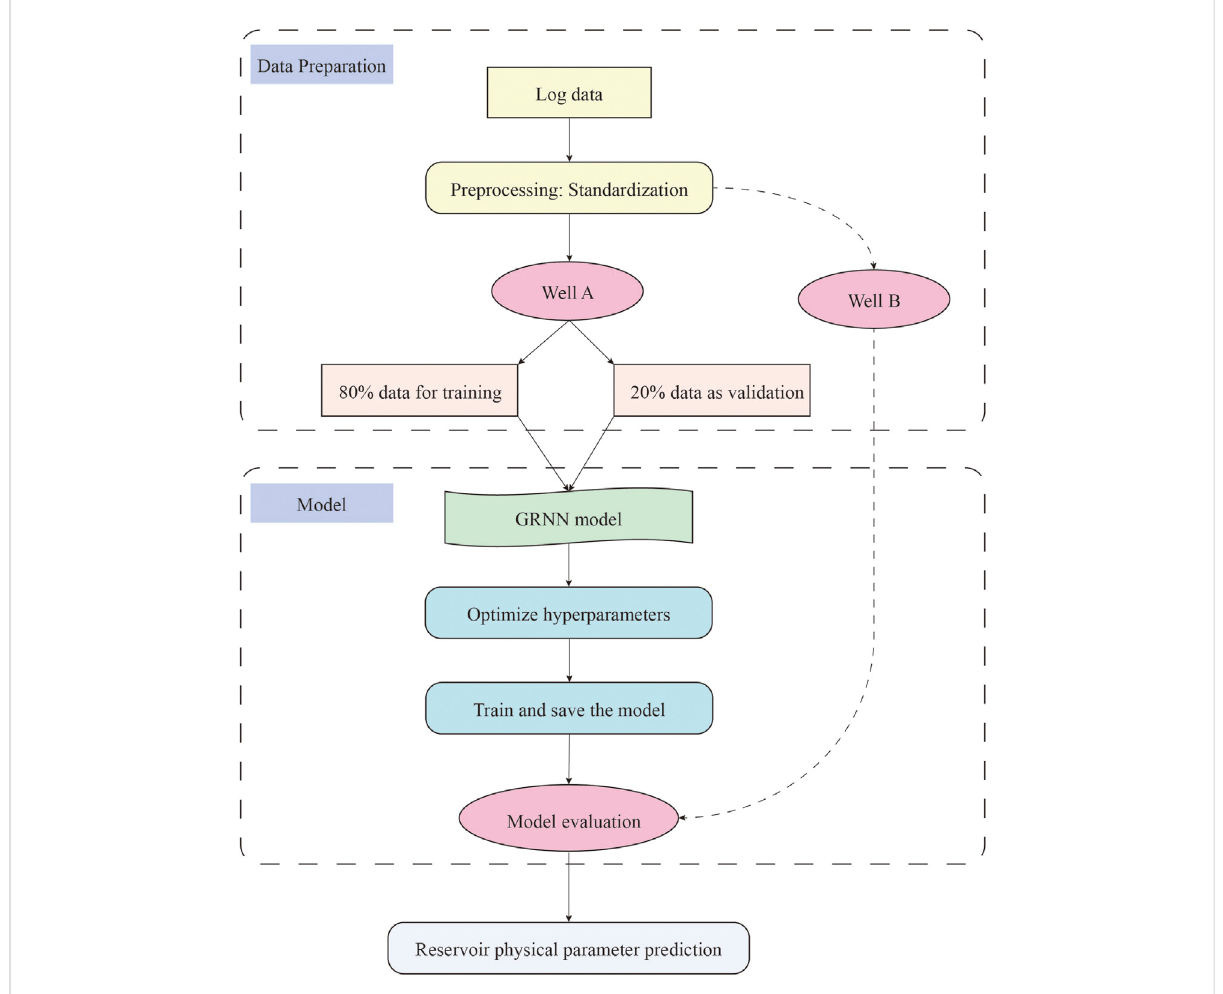
FIGURE 1 Work fl ow. The log data is separated into training, validation, and test sets after being standardized. GRNN model construction and hyperparameter optimization. Test model generalization and predict reservoir physical properties.